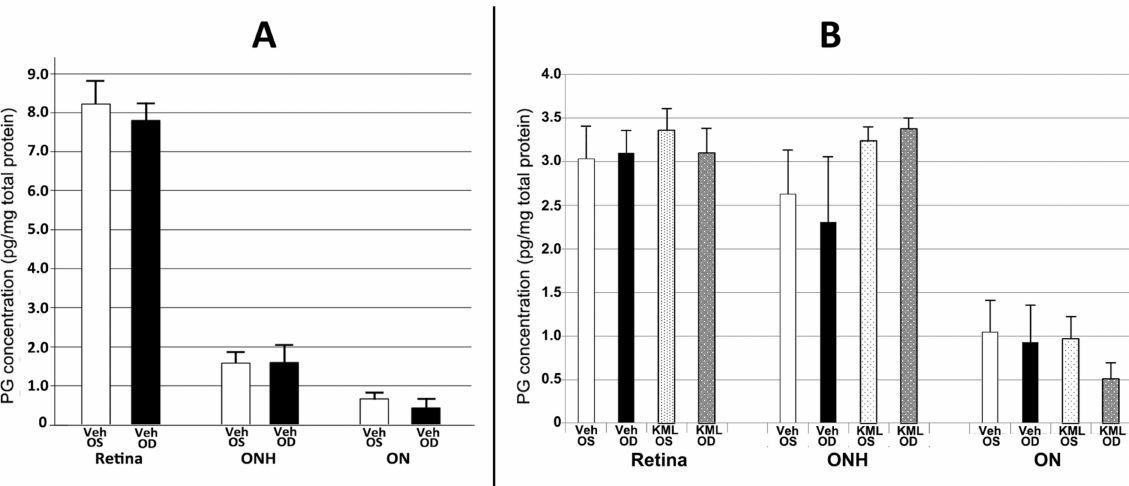
Figure 6. PGJ 2 and PGE 2 levels in the retina, optic nerve head (ONH) and optic nerve, and the effects of KML29 treatment ( n = 3) on PGE 2 . White and black bars represent results from naïve ( n = 3) and vehicle-injected, 1d post-rAION ( n = 3) induced eyes, respectively. ( A ) PGJ 2 levels in retina, ONH and ON. Naïve (Veh OS) retinal PGJ 2 levels are considerably higher (8.22 ± 0.51 (sem) than those of ONH (1.58 ± 0.24 (sem) or ON (0.66 ± 0.06 (sem), respectively, and there is little change 1d after rAION induction (Veh OD). ( B ) PGE 2 levels in retina, ONH and ON and the effects of KML29. PGE 2 levels in the retina are similar in both naïve (Veh OS) and induced (Veh OD) conditions and KML29 does not significantly alter intraretinal expression at one day post-induction (KML OD). KML OS represents the contralateral (uninduced) ocular tissues. PGE 2 - expression is slightly less in ONH, and KML29 slightly upregulates PGE 2 expression. PGE 2 expression is ~2-fold less in the distal ON than in the ONH, and neither rAION nor KML29 significantly affect PGE 2 expression in any tissue. Units are in pg/mg